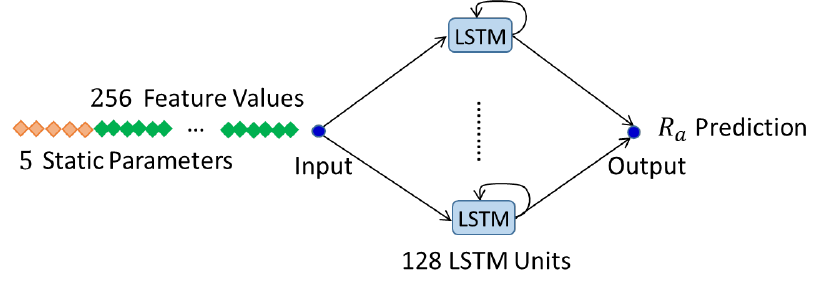
Figure 8. The CNN architecture used in the proposed MTF-CLSTM method.